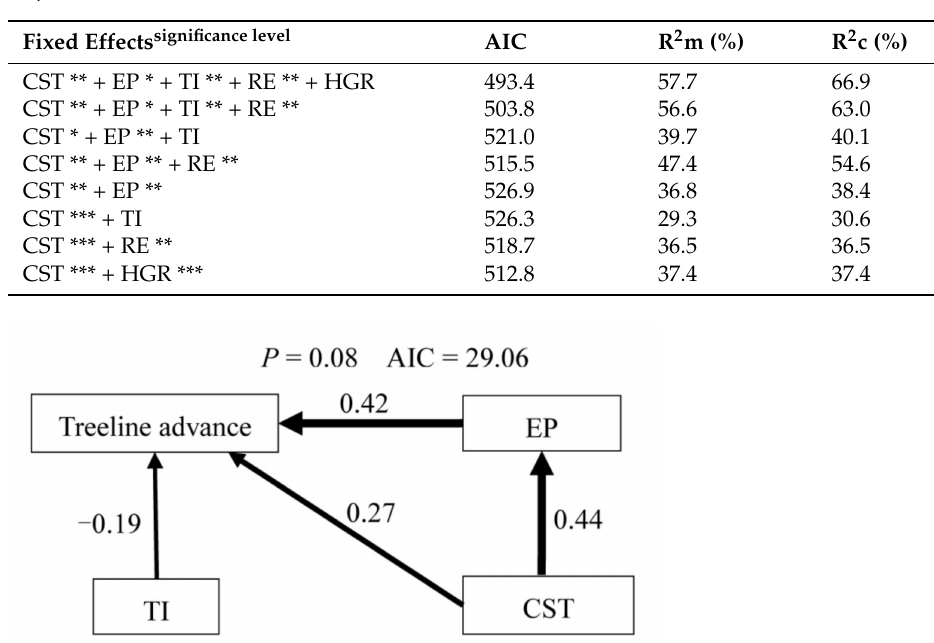
Table 3. Summary of the fitted linear mixed-effects models (LMEs) fitted to treeline data on the Tibetan Plateau. The predictor variables included changes in summer mean minimum temperature (CST), height growth rate (HGR), tree recruitment (RE) and vegetation TI (TI). The subarea was set as the random factor in the LME model. R 2 m and R 2 c denote the marginal R 2 for fixed effects and the conditional R 2 for the fixed and random effects, respectively. Significance: * p < 0.05; ** p < 0.01; *** p < 0.001.